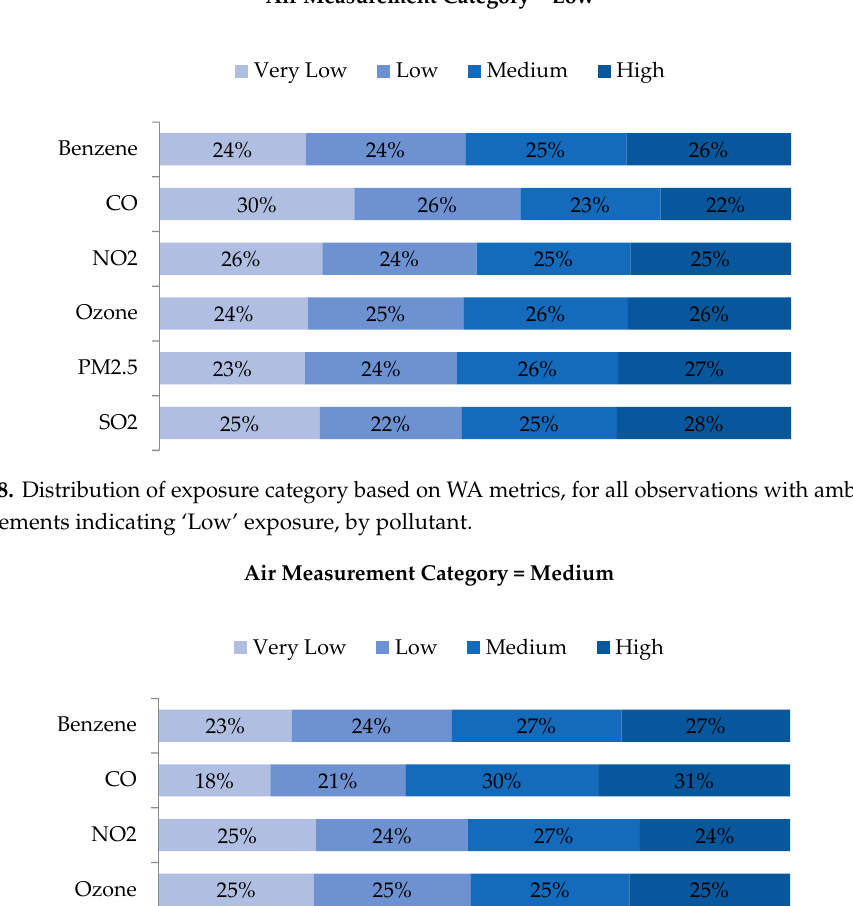
Figure 7. Distribution of exposure category based on WA metrics for all observations with ambient air measurements indicating ‘Very Low’ exposure, by pollutant.